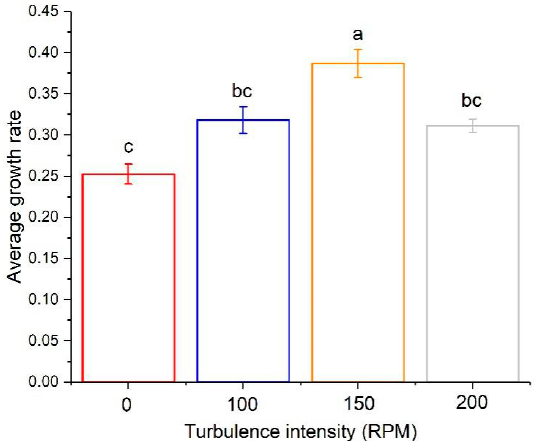
Figure 3. Microcystis aeruginosa ’s growth rate under different turbulent intensities. Different letters indicate significance between different treatments ( p < 0.05). (cid:3039)(cid:3041)(cid:4672) (cid:3299)(cid:3289) (cid:3299)(cid:3289)(cid:3127)(cid:3117) (cid:4673) Growth rate μ = , where 𝑥 (cid:3041) is algal biomass for the day; 𝑥 (cid:3041)(cid:2879)(cid:2869) is biomass for (cid:3047) (cid:3289) (cid:2879)(cid:3047) (cid:3289)(cid:3127)(cid:3117) the last day; and 𝑡 (cid:3041)(cid:2879)(cid:2869) is cultivation time corresponding to 𝑥 (cid:3041) and 𝑥 (cid:3041)(cid:2879)(cid:2869) . Error bars rep- resent the SD of triplicate samples.